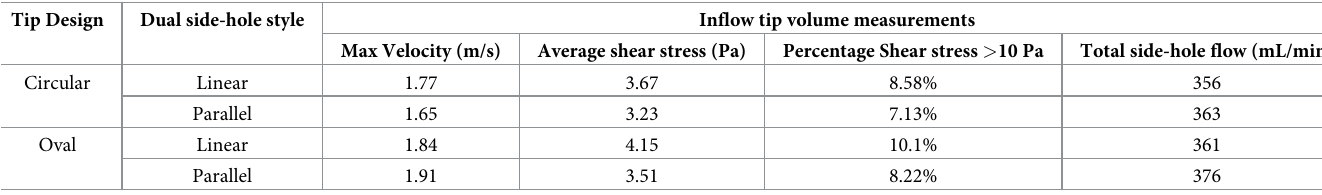
Table 4. Tip volume parameters for the dual side-hole